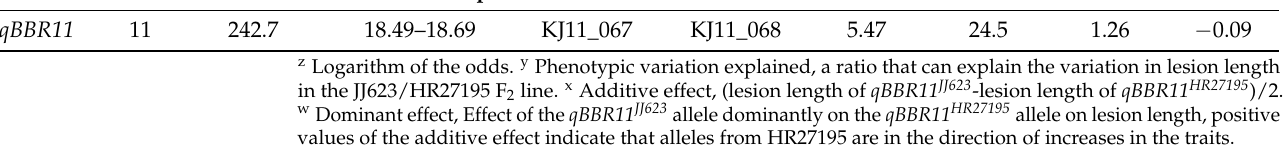
Table 3. Details of QTLs related to BB resistance from the F 2 line derived between JJ623 and HR27195. QTL